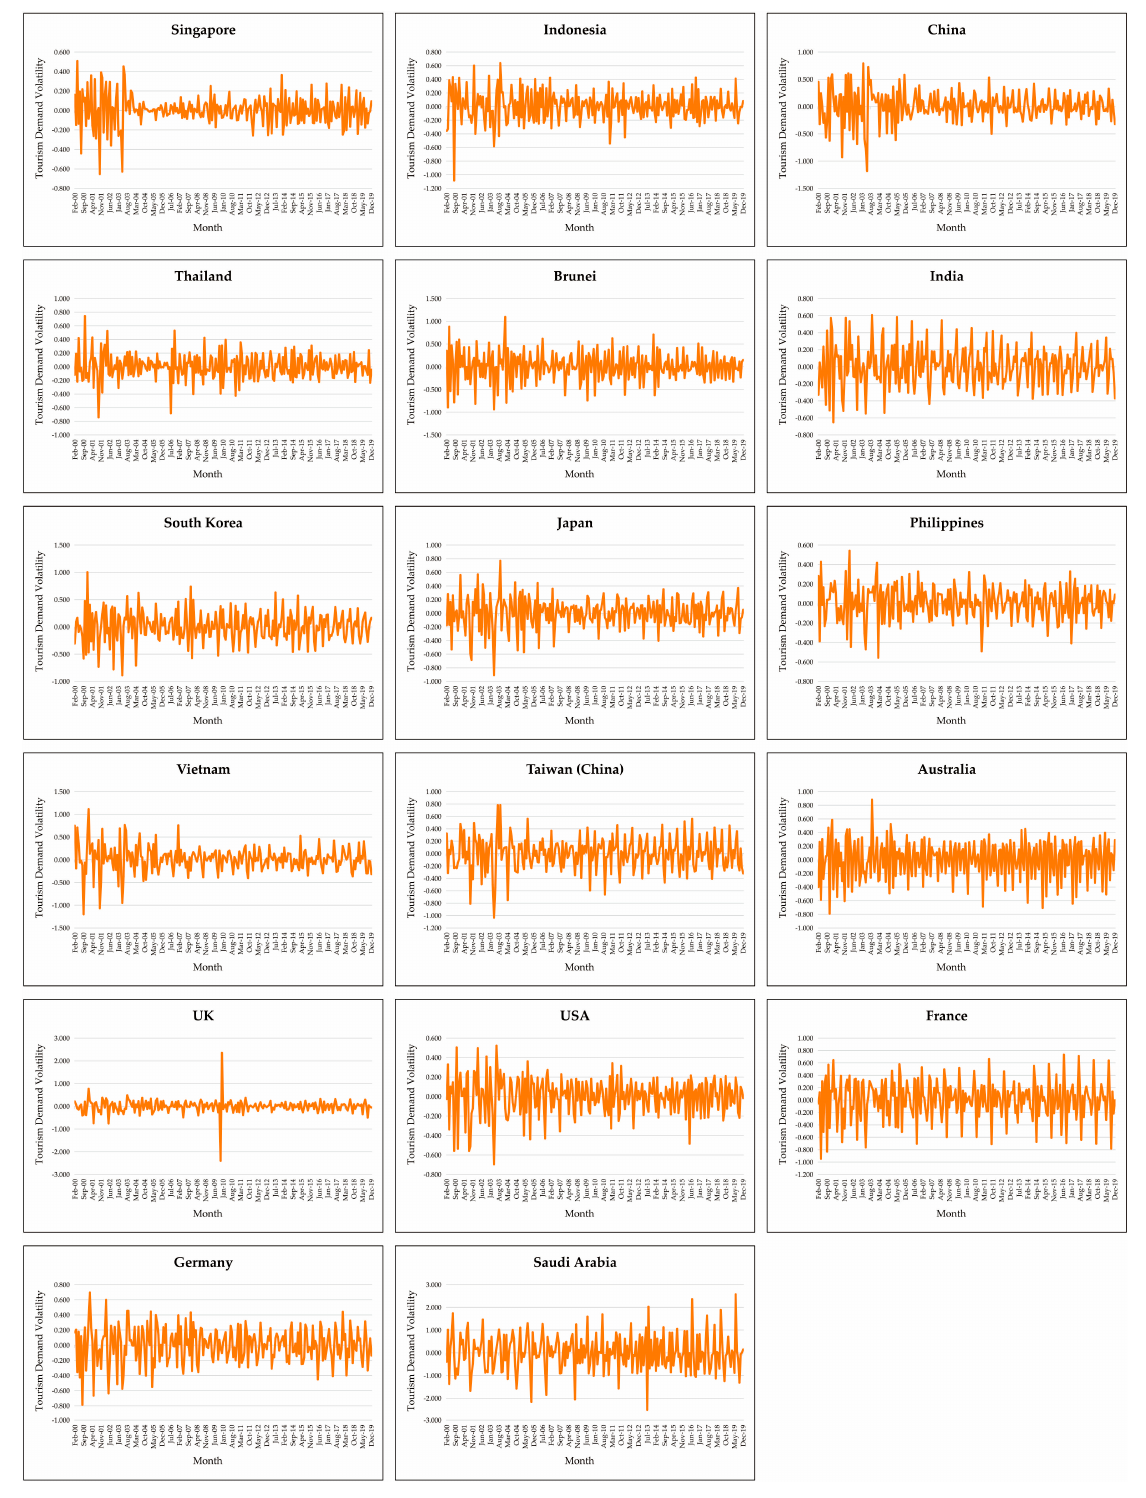
Figure 2. Volatility of seventeen monthly tourist arrivals into